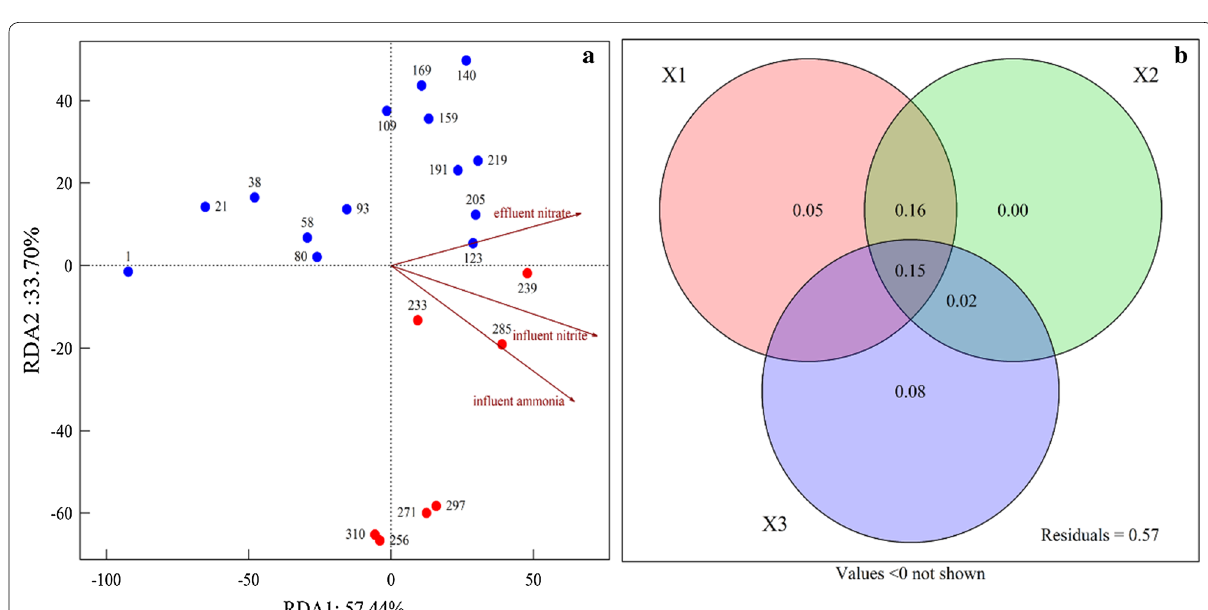
Fig. 4 a Effects of environmental variables on bacterial community dynamics, from RDA based on Illumina MiSeq data. Numbers: sampling dates. Blue, red, and orange as in Fig. 3. Arrows: direction and magnitude of environmental variables driving bacterial community dynamics. Environmental factors were selected based on significance ( p < 0.05) calculated from Mantel test results. b Relative contributions of environmental variables on bacterial community dynamics, from VPA. X1: influent ammonia; X2: influent nitrite; X3: effluent